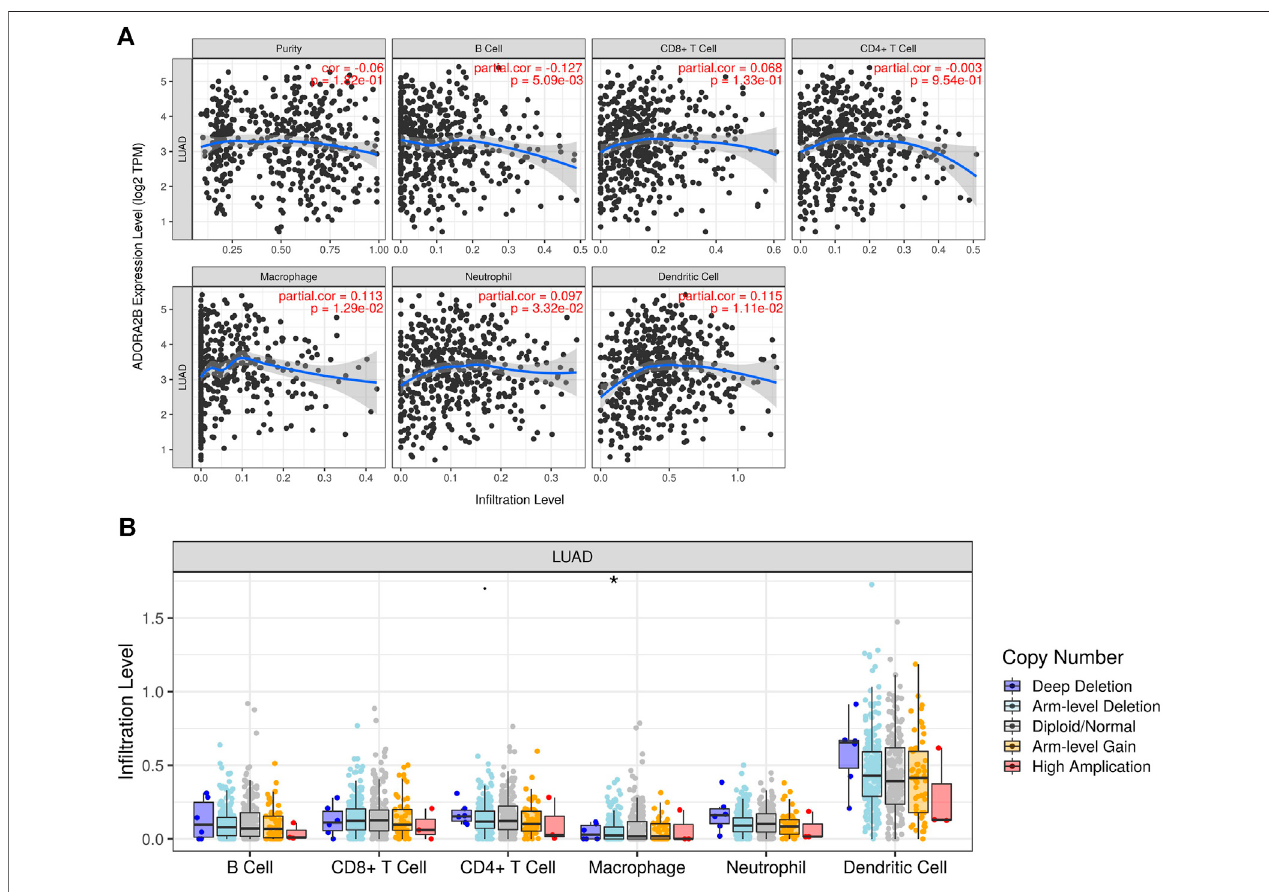
FIGURE 7 | Correlation of ADORA2B expression with immune cell in fi ltration in LUAD. (A) Correlation of ADORA2B with tumor purity and in fi ltration of different subsets of immune cells. (B) Effect of copy number variation of ADORA2B on the distribution of various immune cells. * p < 0.05 is statistically signi fi cant.